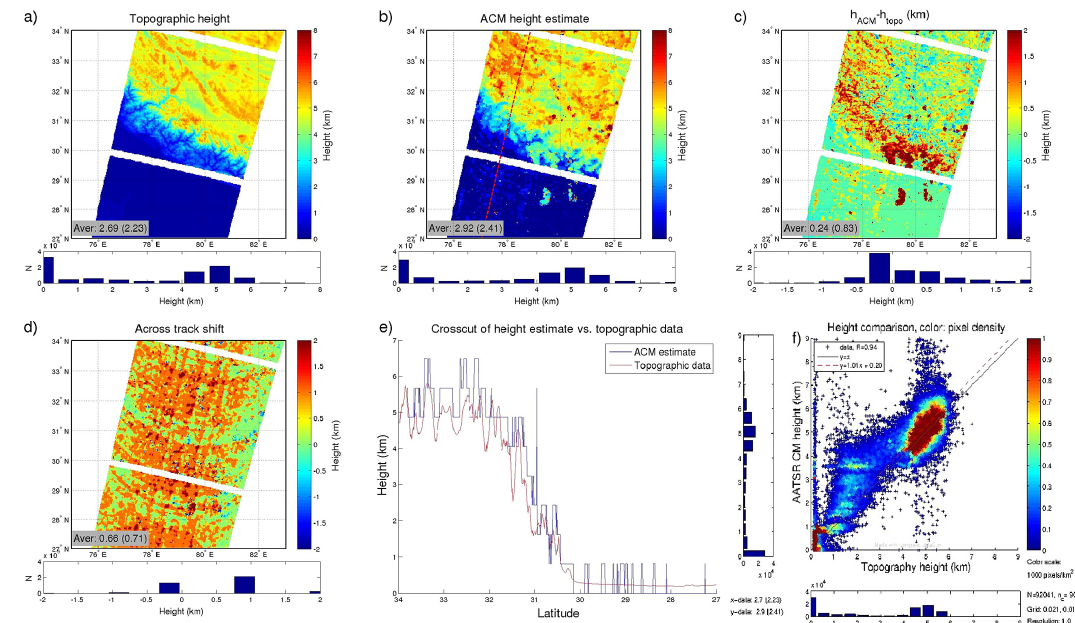
Figure 10. (a) Topographic data over the Himalayas, (b) AATSR height estimate, (c) their difference, (d) the across-track pixel shift, (e) a crosscut height profile, and (f) the scatterplot for topographic height and ACM estimate. Some cloud contamination can be seen in the ACM height estimate, particularly on the southern edge of the mountain range. These cause the largest differences, seen as the red areas in panel (c) , narrow peaks in panel (e) , and as large scatter in panel (f) . The crosscut is indicated in panel (b) as the dashed red line. The vertical resolution of roughly 1km is clearly seen in the height estimate profile (e) , as well as the jumping of the algorithm between 0 and 1km in the lower plains. Panel (d) shows features resembling the conical scanning geometry of AATSR and may indicate ground level collocation